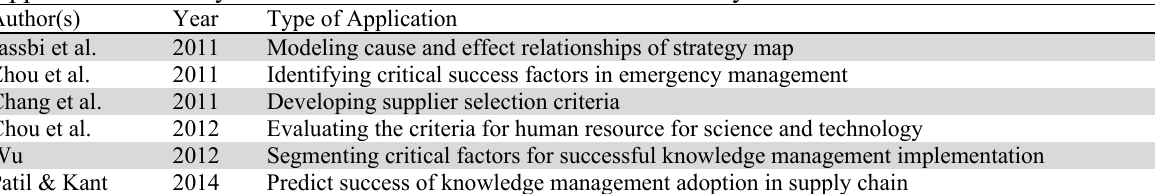
Application of Fuzzy DEMATEL in Critical Success Factors analysis